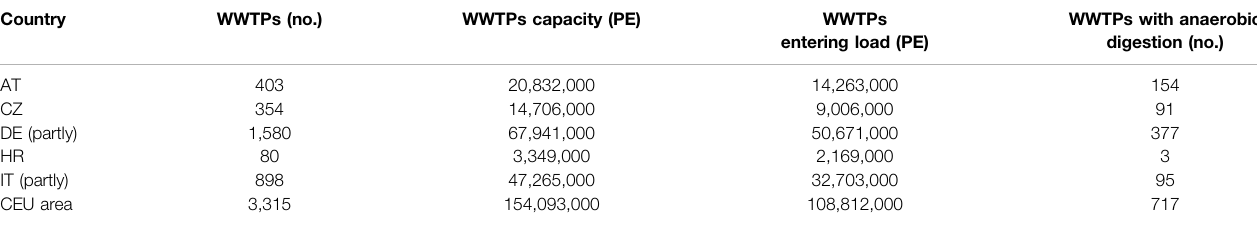
TABLE 5 | Technical inventory of WWTPs per country (REEF 2W eBook, s.a. adapted). Country WWTPs (no.) WWTPs capacity (PE)